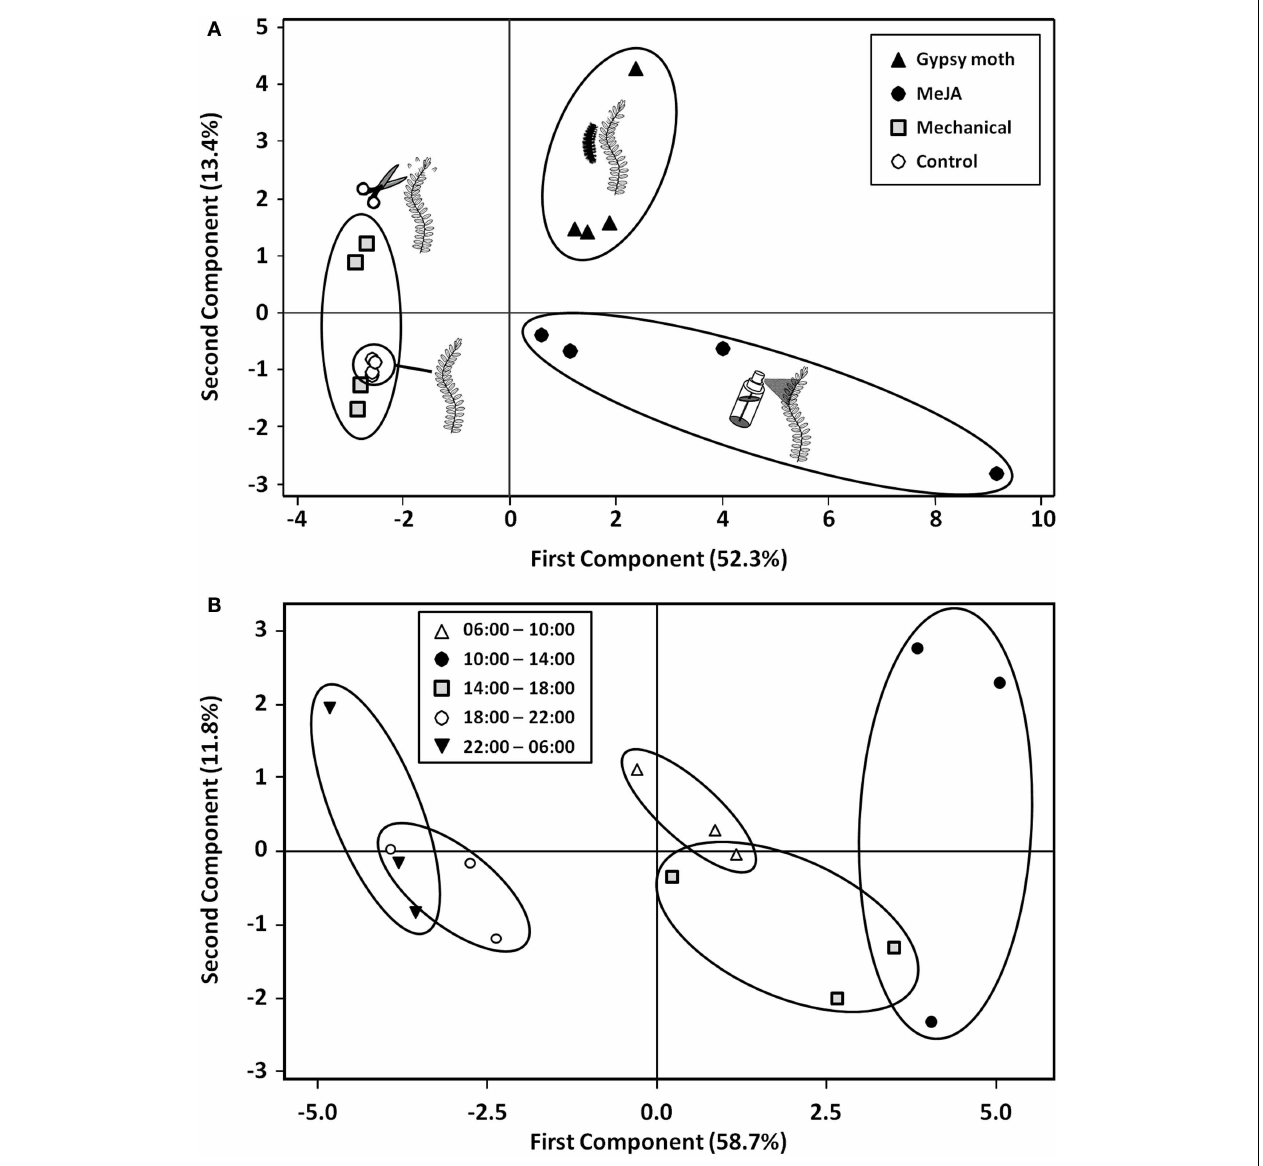
FIGURE 2 | Score plot of principal component analysis (PCA) for (A) the effects of gypsy moth larval feeding, MeJA, and mechanical damage as compared to control plants on the volatile profiles of cranberries